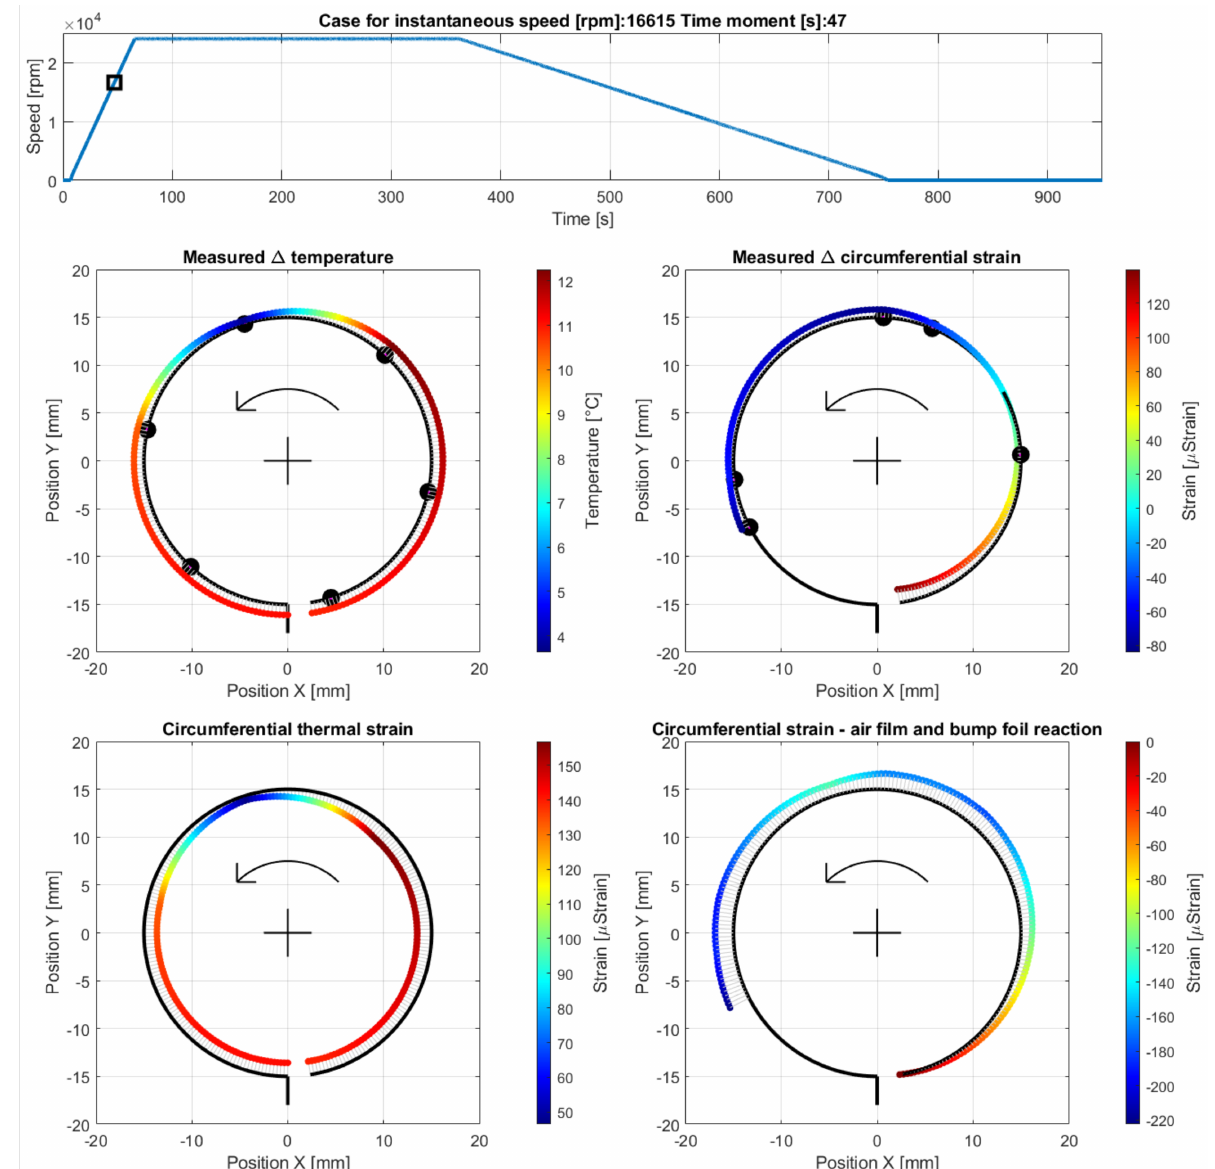
Figure 12. Cross-sectional views for the circumferential distribution of the temperature and strain identified in the top foil at 16,615 rpm during the run-up stage of the GFB’s operation before the homogenization of the temperature. The black square and arrows respectively indicate the actual rotational speed of the shaft and its